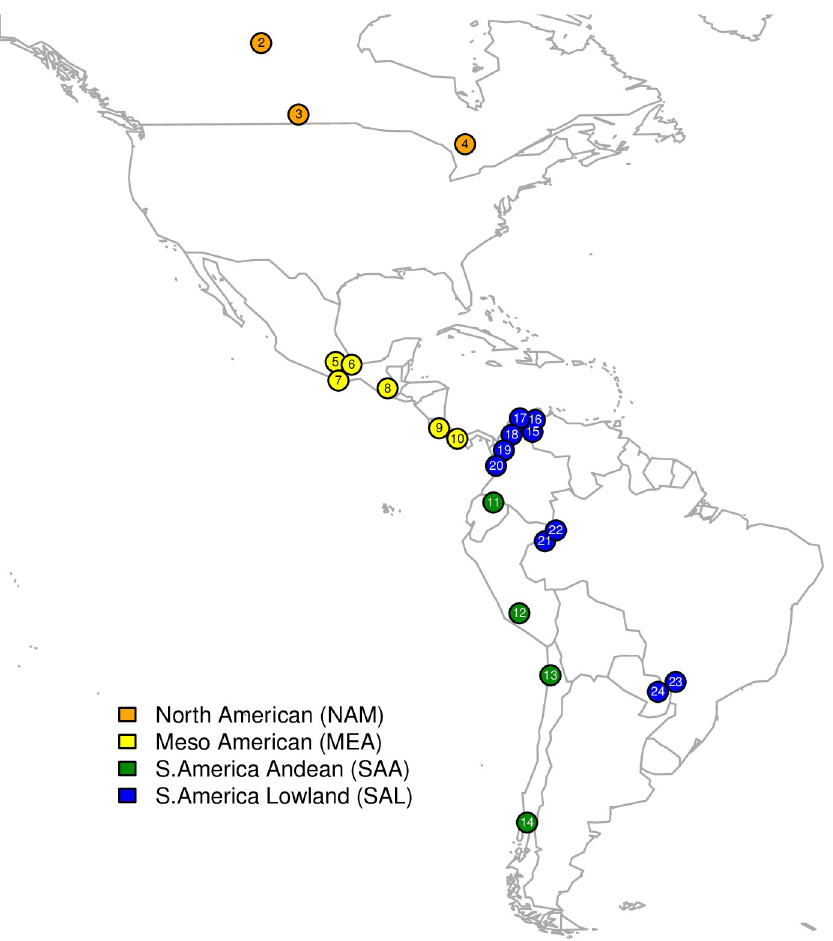
Fig 1. Map of North and South America with location of Native American populations studied. Locations indicated based on geographic coordinates given in Table 1.